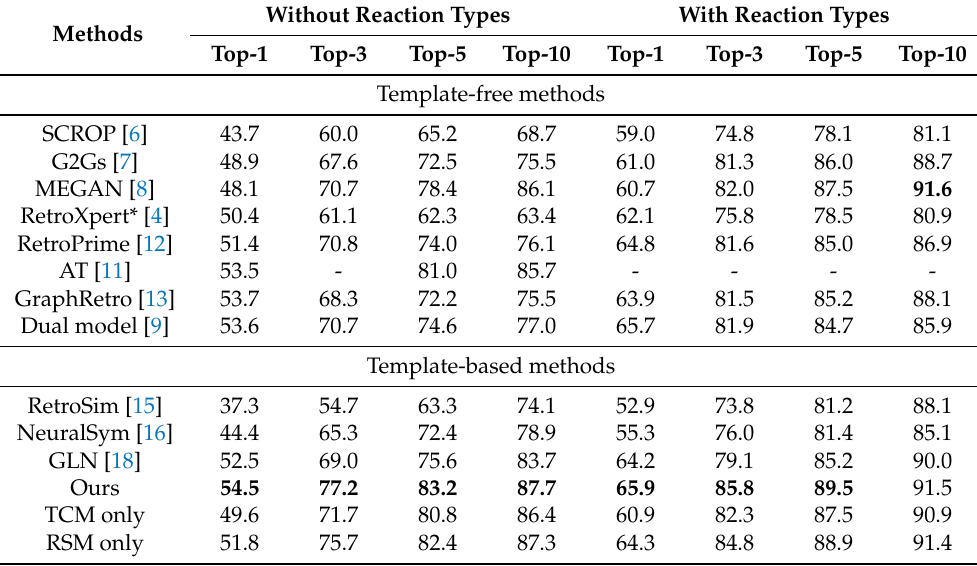
Table 1. Retrosynthesis evaluation results (%) on USPTO-50K. Existing methods are grouped into two categories. Our method RetroComposer belongs to the template-based methods. The best results in each column are highlighted in bold. RetroXpert* results have been updated by the authors in their GitHub repository (https://github.com/uta-smile/RetroXpert (accessed on 20 March